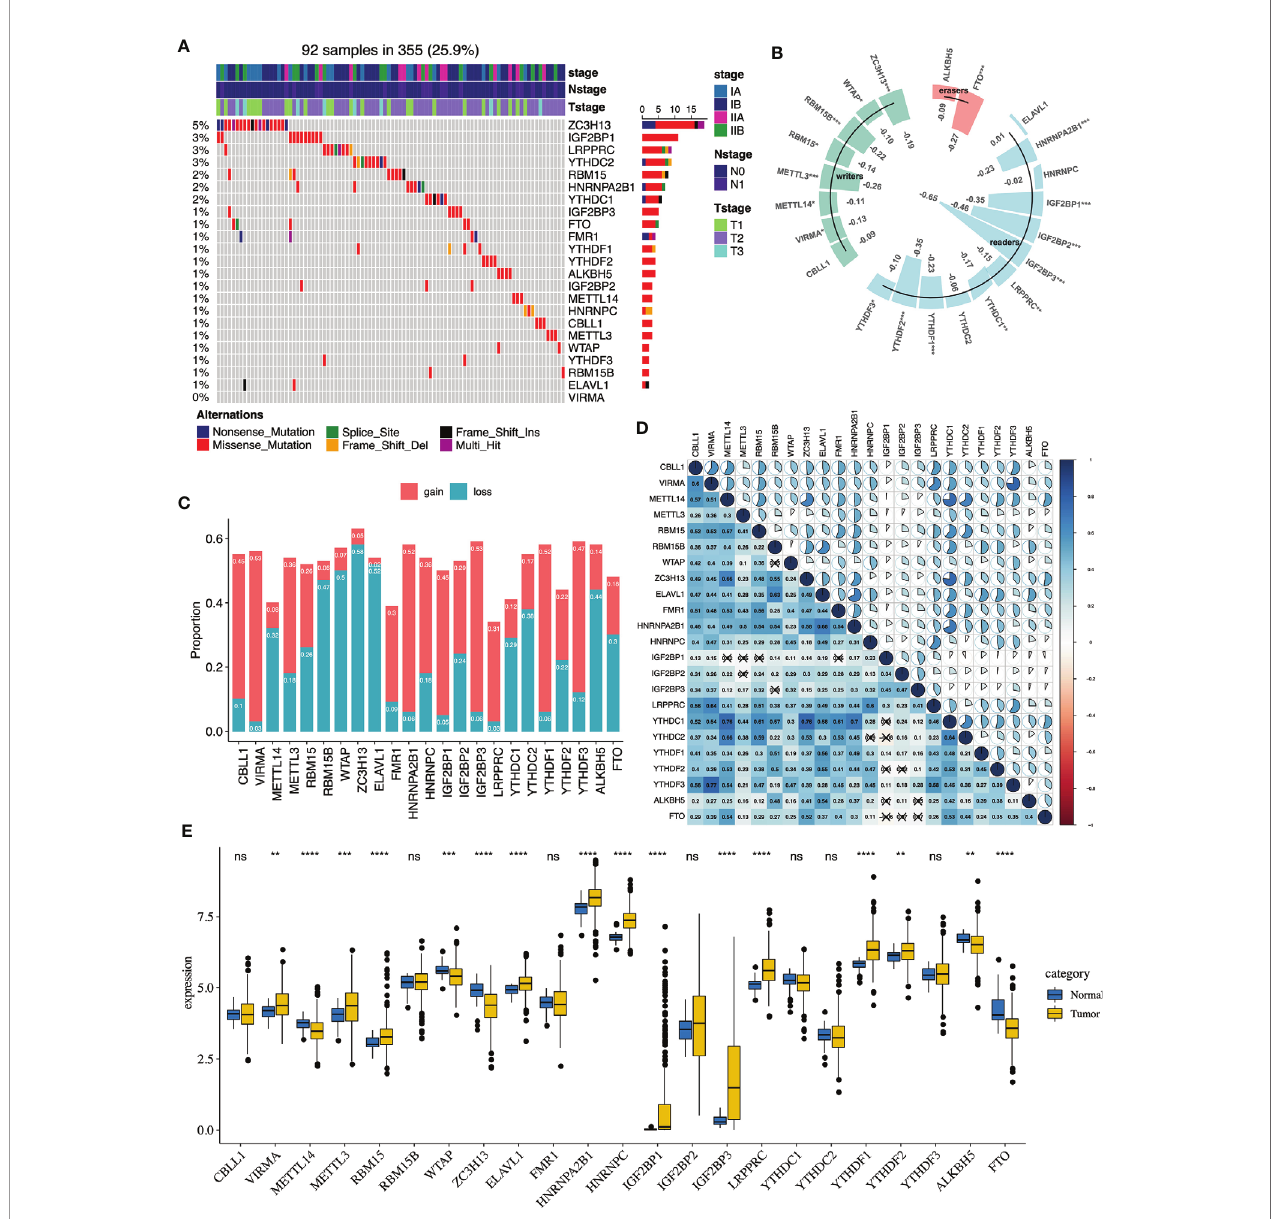
FIGURE 1 | The genetic features of 23 m 6 A regulators in early-stage lung adenocarcinoma of the TCGA cohort. (A) The genetic mutations of 23 m 6 A regulators in 92 patients. (B) The correlation analysis between DNA methylation and 23 m 6 A regulators ’ expression (*P < 0.05; **P < 0.01; ***P < 0.001). (C) The CNA landscape of 23 m 6 A regulators. Gain represents gain and high level ampli fi cation, loss represents homozygous deletion and hemizygous deletion. (D) The correlation analysis between the 23 m 6 A regulators via the Spearman correlation method. (E) The m 6 A regulators expression between normal and tumor groups (*P < 0.05; **P < 0.01; ***P < 0.001; ****P < 0.0001). ns, not signi fi